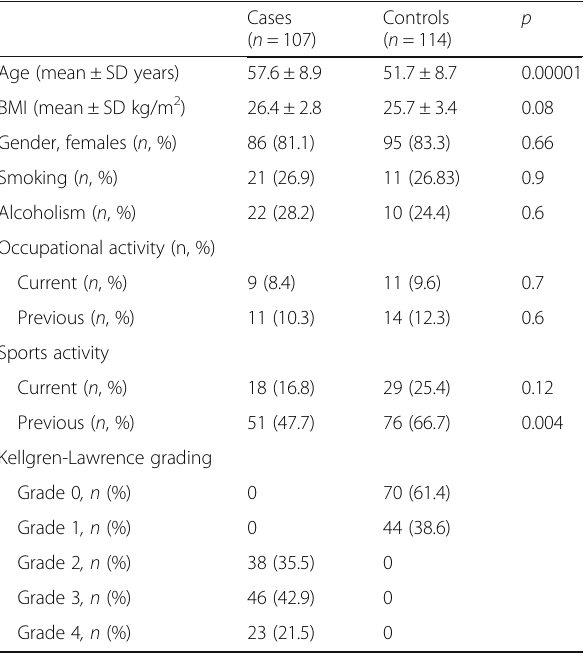
Table 2 General characteristics of the study population